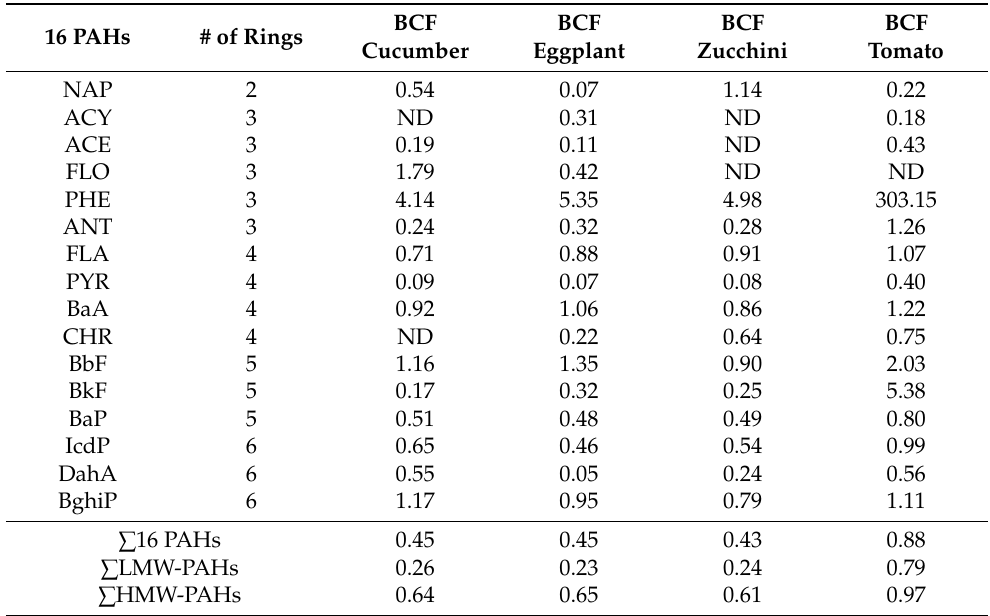
Table 3. Bioconcentration factor (BCF) of vegetables collected from King Talal Dam (KTD) and south of Deir Alla (SDA) in the Jordan